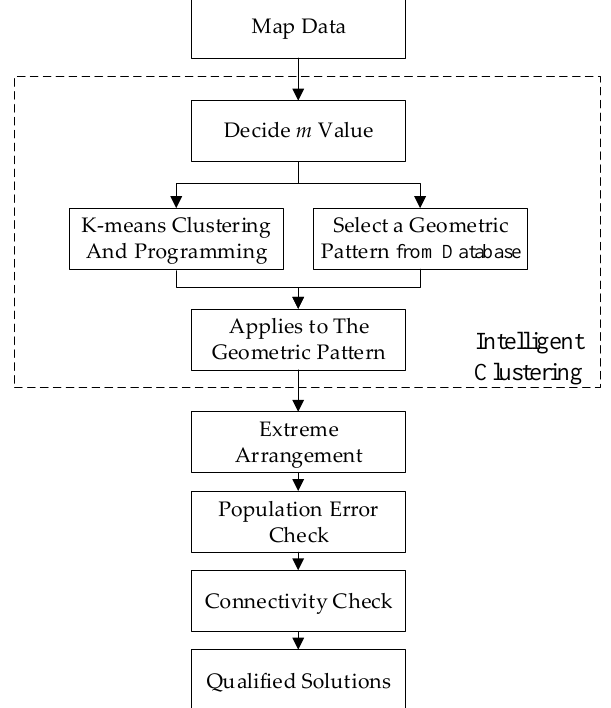
Figure 3. System architecture of computing and mechanism is integrated for electoral districting.